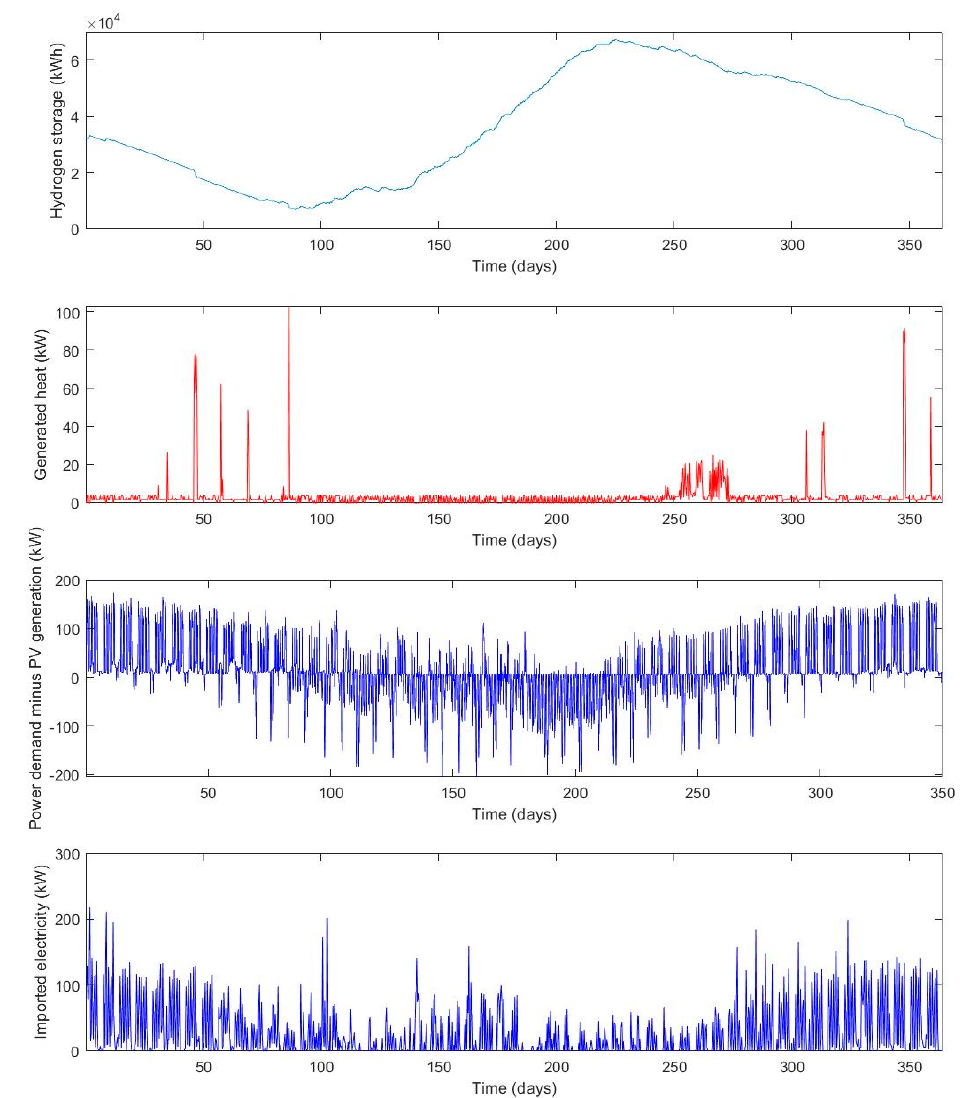
Figure A2. Optimal operation of a 20/80 kW RSOC system with 2000 m 2 solar PV panel.